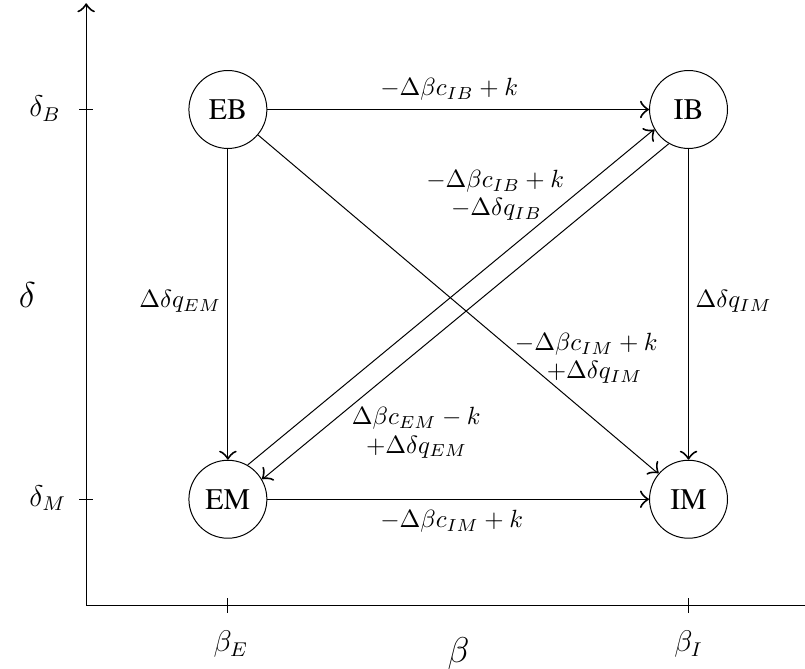
Figure 1. Downward and diagonal incentive